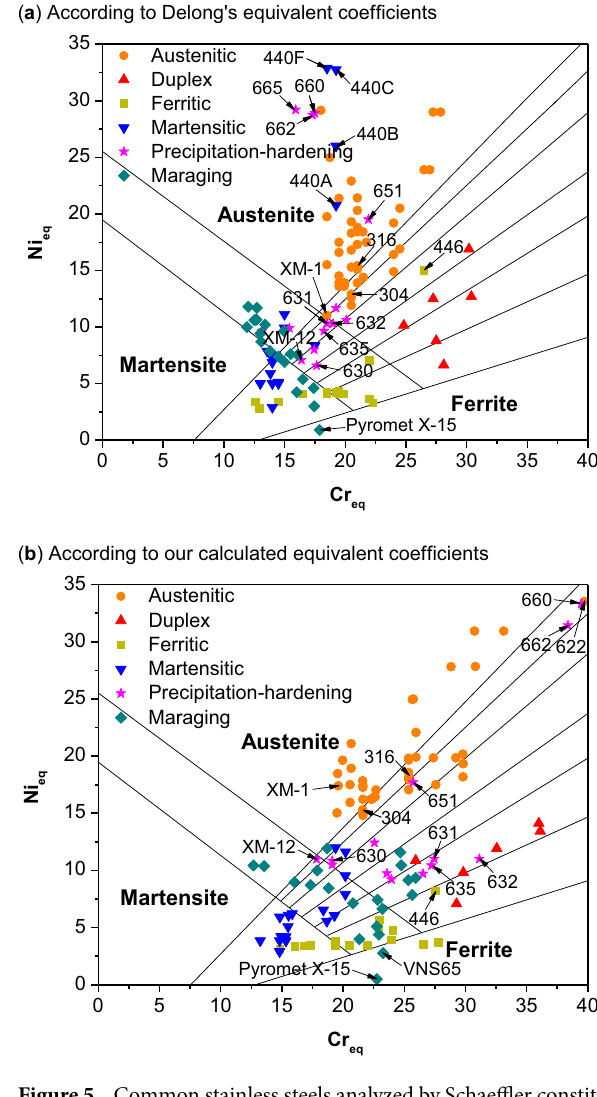
Fig. 5b. The same applies to ferritic 446 with a C content of 0.2 wt%: it is shifted to pure ferrite zone after using the calculated coefficients.